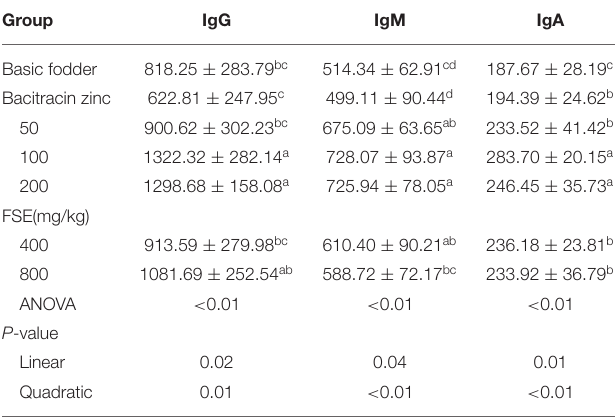
TABLE 7 | Effects of fenugreek seed extract on serum immunoglobulin in broilers 1 .